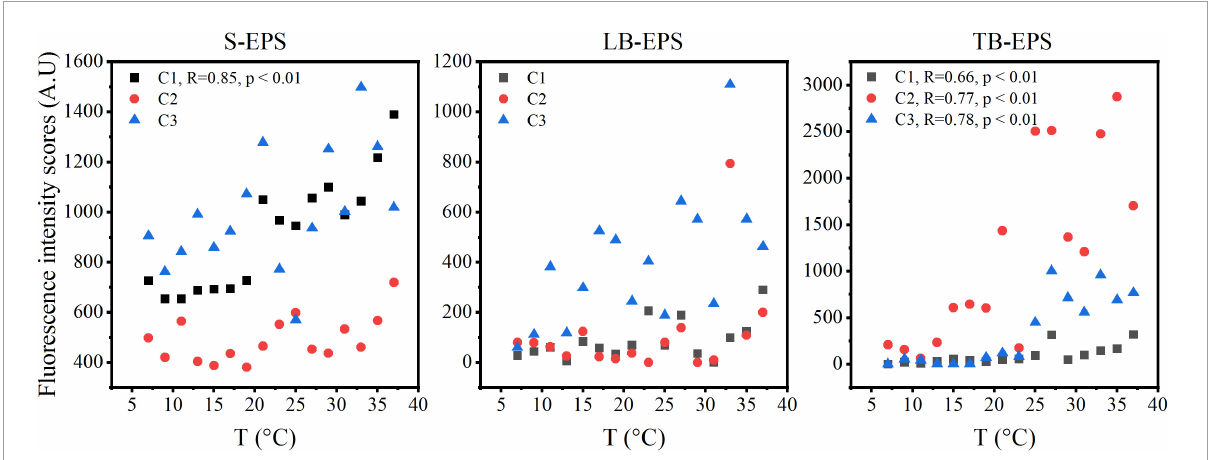
FIGURE5 The scatter plots of fluorescence intensity scores in different EPS fractions with increasing temperature of A. flos-aquae (C1 and C2 defined as humic-like substances, C3 defined as tryptophan-like substances; R stands for Pearson correlation coefficient; p represents the significance level).